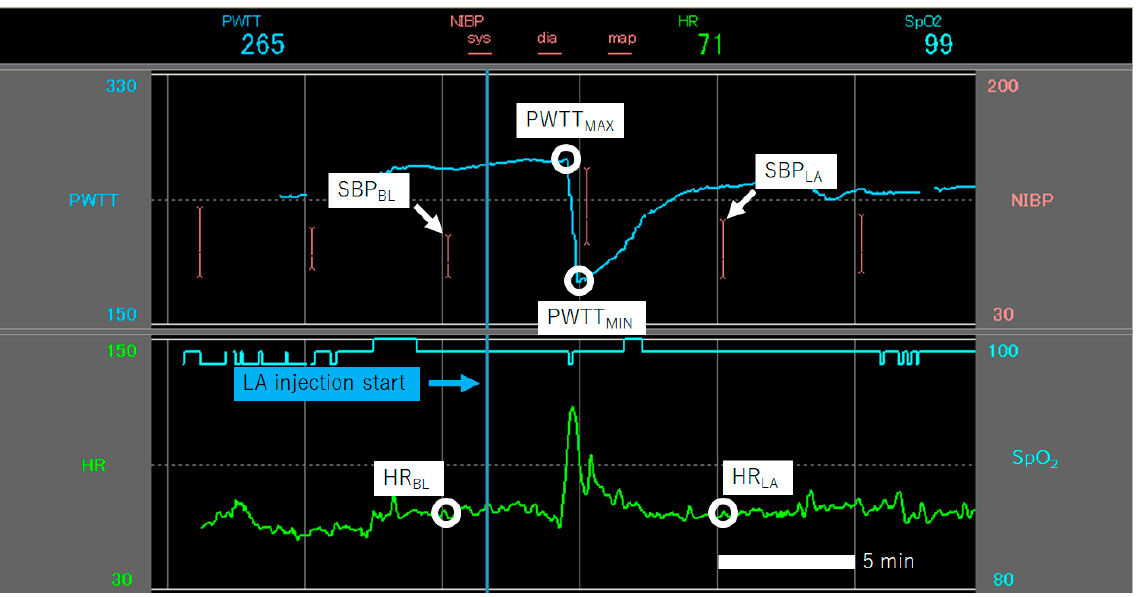
Figure 1. Baseline HR (HR BL ) and baseline SBP (SBP BL ) immediately before local anesthesia; heart rate after local anesthesia (HR LA ); and systolic blood pressure (SBP LA ) were also recorded at 5 min after local anesthesia. Value for Δ PWTT. Crest PWTT wave (PWTT MAX ) value; trough PWTT wave (PWTT MIN ) value. Unit PWTT in milliseconds (msec), SBP in mmHg, HR in beats per minute (bpm). Abbreviations: HR = heart rate; SBP = systolic blood pressure; PWTT = pulse wave transit